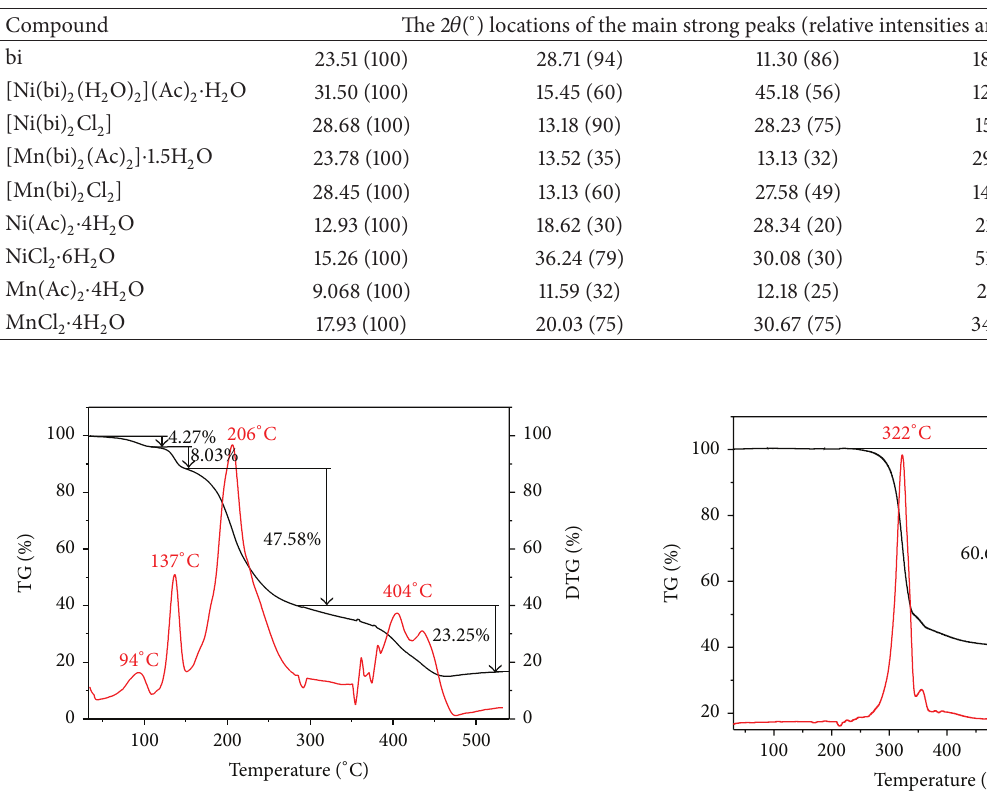
Figure 10: TG-DTG curves of complex 1 . Figure 11: TG-DTG curves of complex 2 .